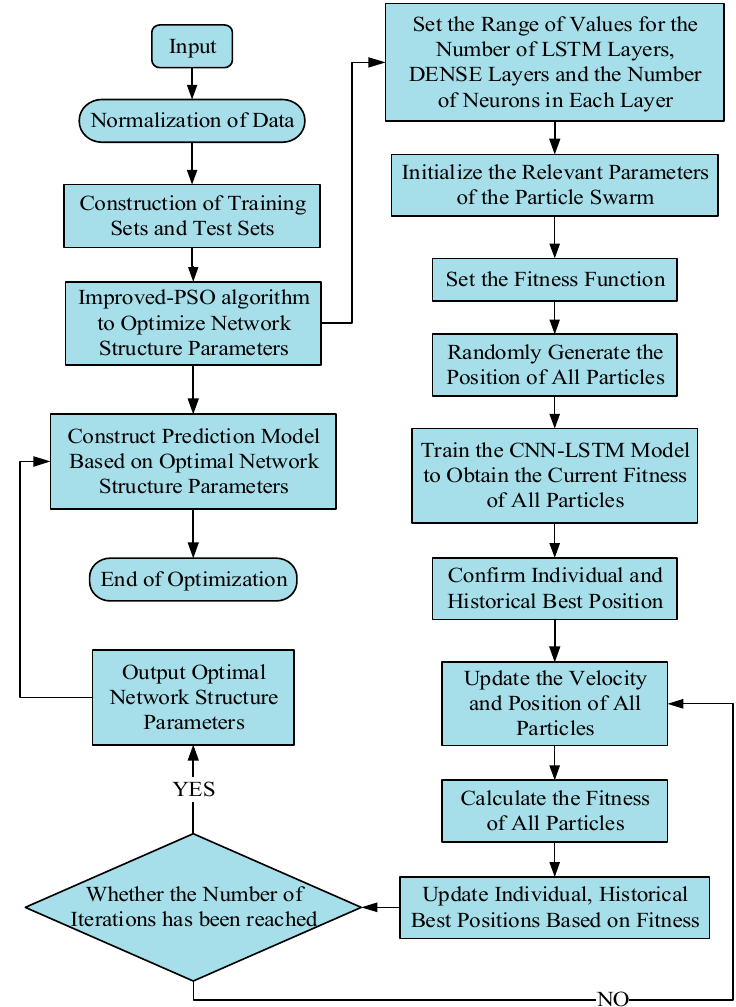
Figure 3. Flow chart of optimizing parameters for combined neural network structure by IPSO.